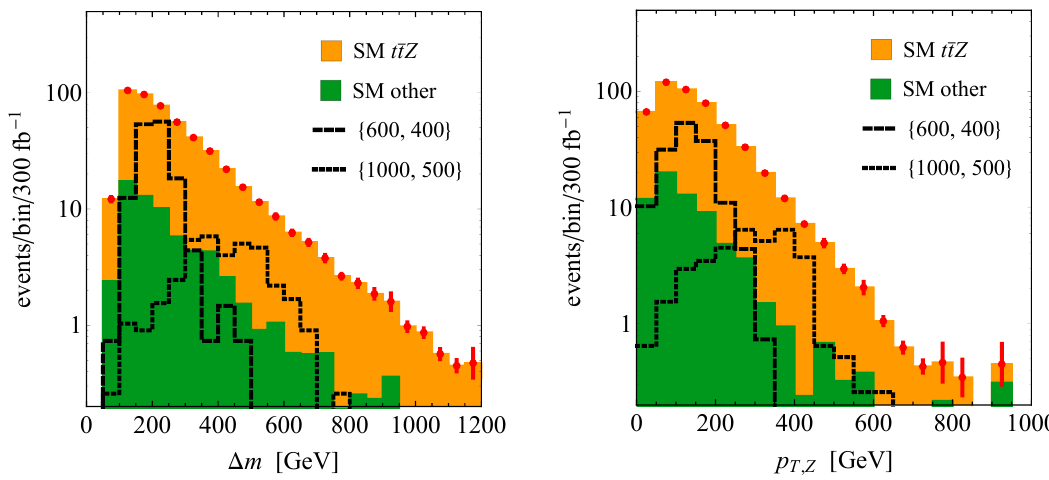
Figure 7 . Distributions of (cid:1) m (left panel) and p T;Z (right panel) after imposing the experimental selection requirements as detailed in the text. The coloured histograms are stacked and represent the SM backgrounds with the label \SM other" referring to the contributions from tbW , WZ , tZ and tWZ . The shown error bars represent the statistical uncertainties of the sum of the SM backgrounds. The signal predictions in the type-II 2HDM corresponding to M H = M = 600 GeV, M A = H (cid:6) 400 GeV ( M H = M = 1000 GeV, M A = 500 GeV), c (cid:12) (cid:0) (cid:11) = 0 and t (cid:12) = 1 are superimposed as H (cid:6) p dashed (dotted) black lines. All predictions are obtained at s = 14